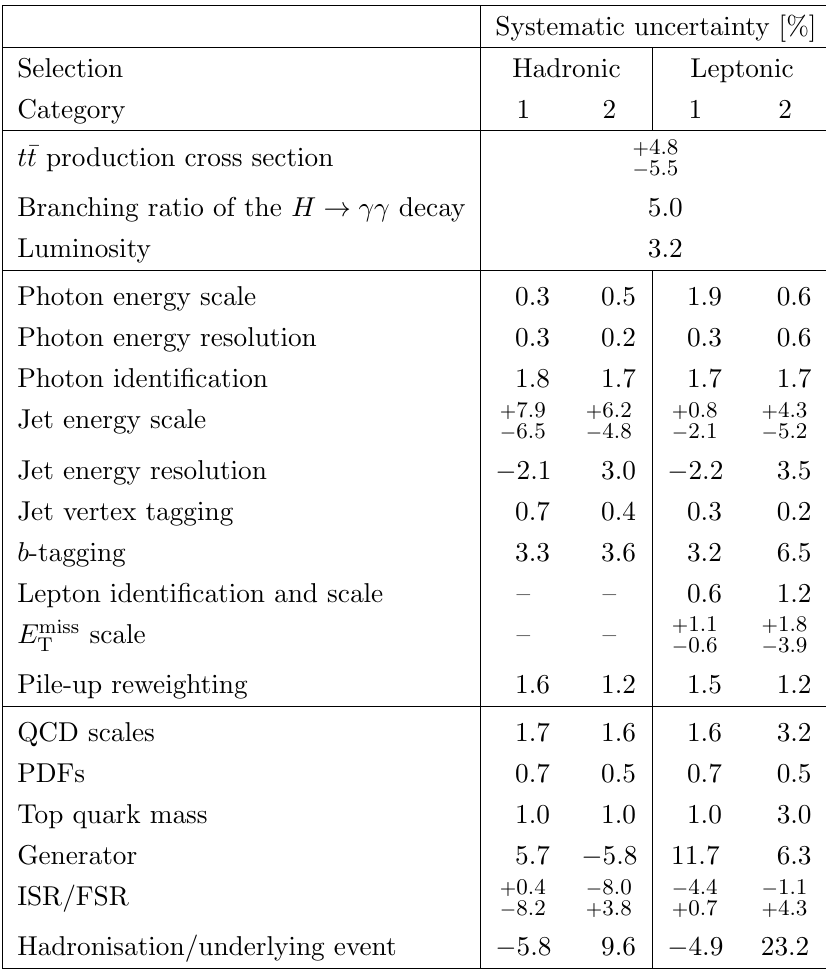
Table 2. Summary of theoretical, experimental and generator (see text) relative uncertainties in the signal yields, for the hadronic and leptonic selections (in percent, per event). The top three rows a(cid:11)ect only the normalisation. The uncertainty related to the photon and lepton isolation selections is included in the identi(cid:12)cation